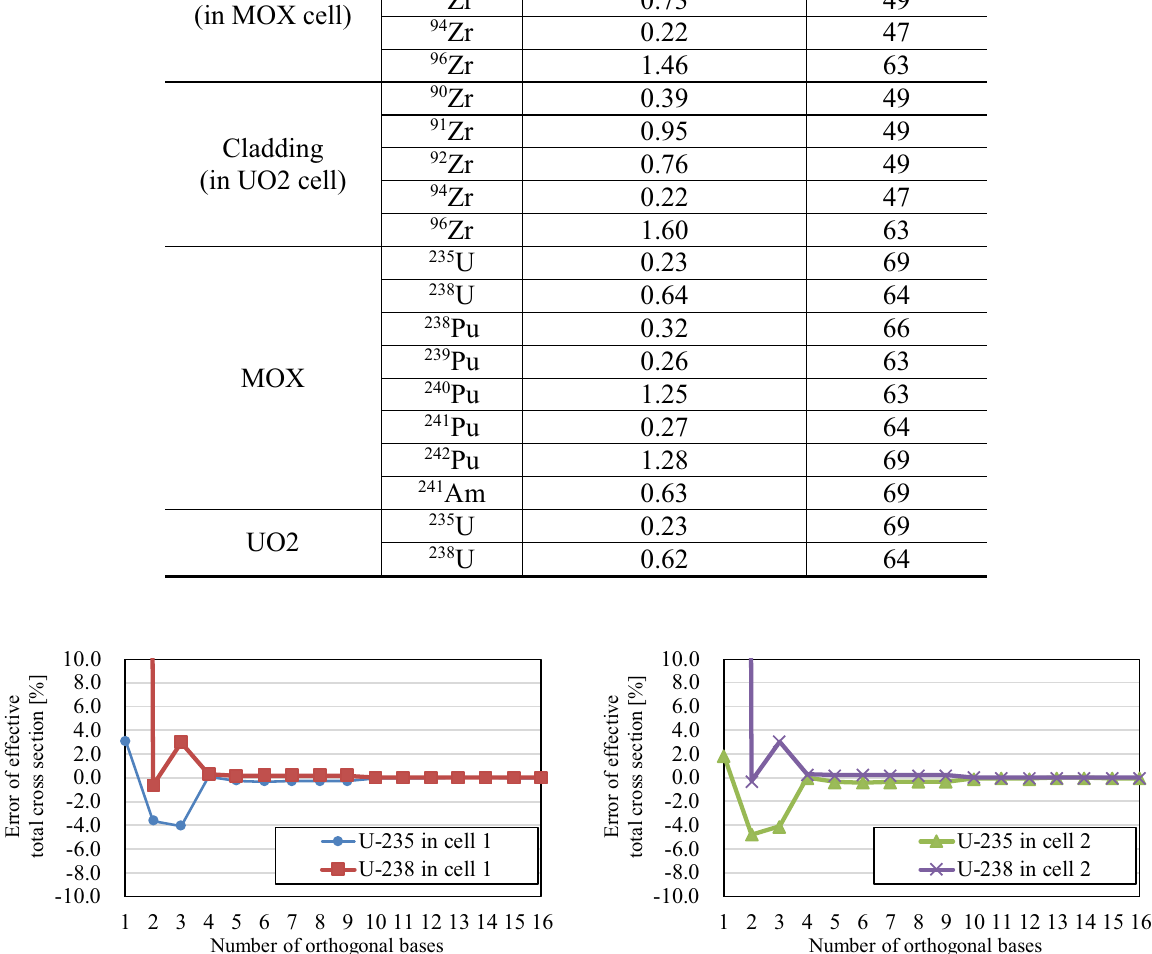
Figure 2. Comparison of effective total cross section in group 88 for various number of orthogonal bases in Fig.